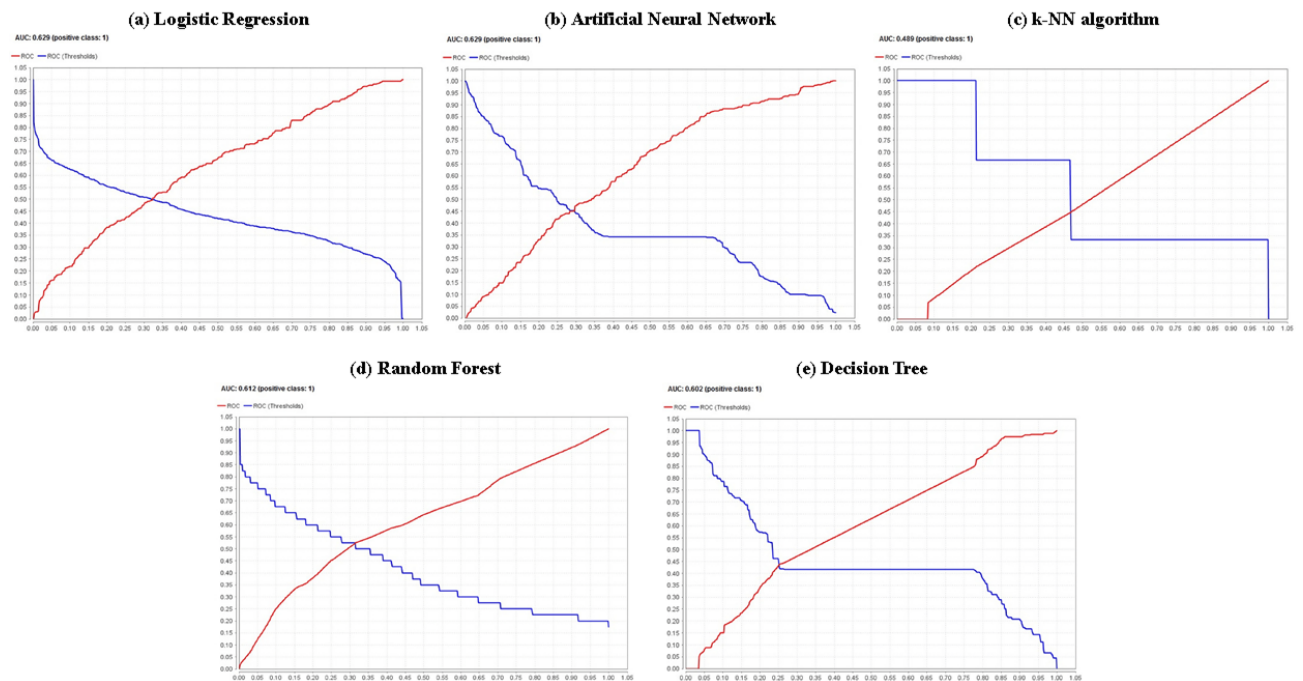
Figure 6. ROC curves and AUC values associated with the parametric and non-parametric classifica- tion models for the test